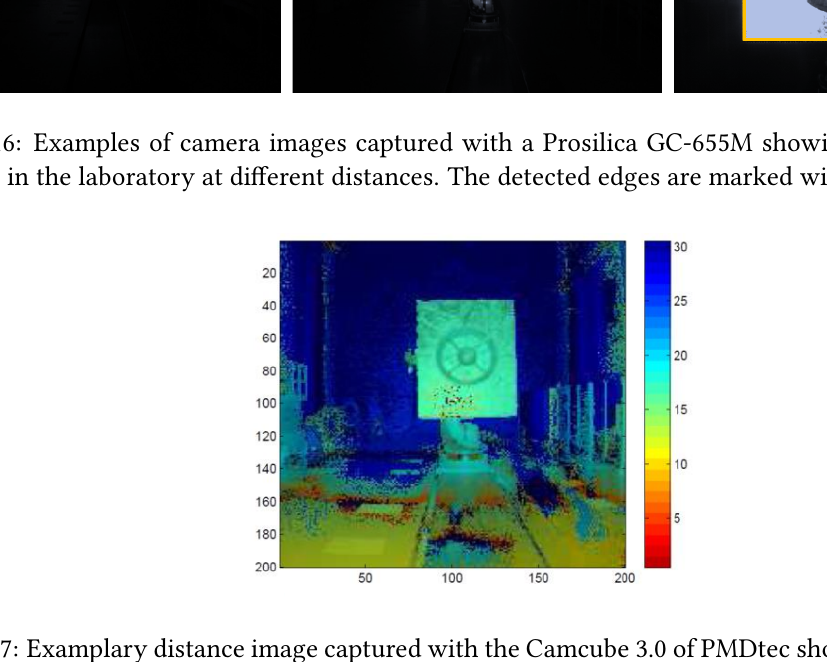
Figure 17: Examplary distance image captured with the Camcube 3.0 of PMDtec showing a client satel- lite mockup in the laboratory. The distance information is visualized with different